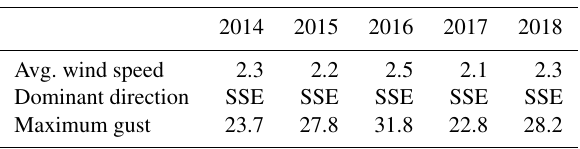
Figure 16. Average cumulative monthly rainfall data histogram for 2014–2018. Diagram also reports average monthly values of rain- fall, measured at the Meteorological Observatory of University of Naples “Federico II” since 1872 (Mazzarella, 2006). Rainfall val- ues are reported in blue square cells and red square cells. Table 8. Annual average values of wind measures during 2014–